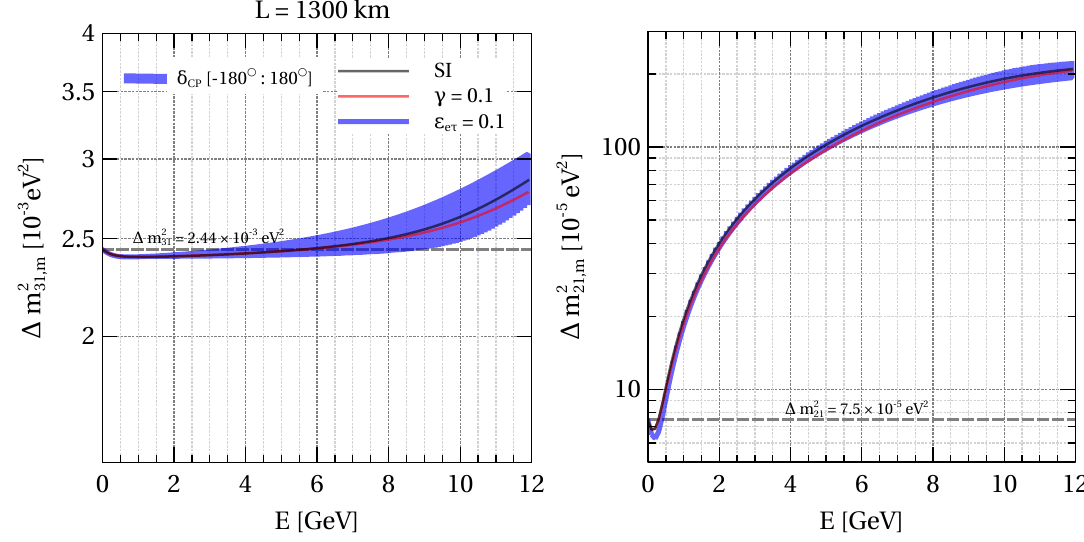
(left panel) and ∆ m 2 31 ,m 21 ,m (blue curves) with strength eτ in the range of CP and ∆ m 2 do not depend on 31 ,m 21 ,m = 45 ◦ assuming 23